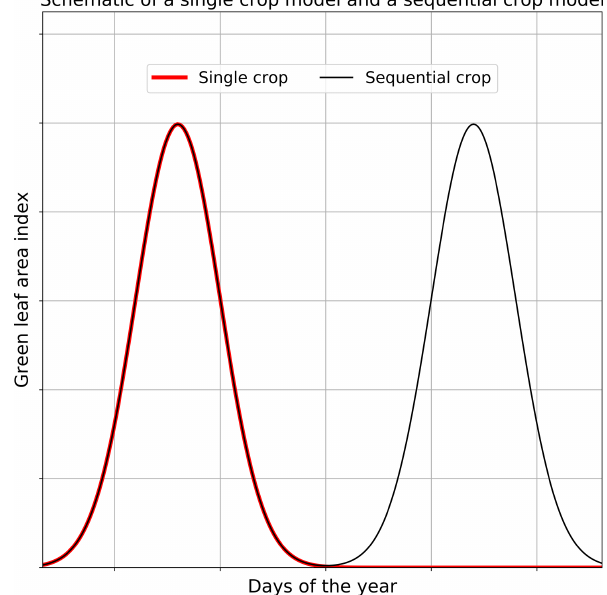
Figure 1. A schematic describing the single-crop model (red curve) that is part of the standard JULES-crop and the new option for in- cluding sequential cropping (black curve). This schematic repre- sents a generic crop at a single